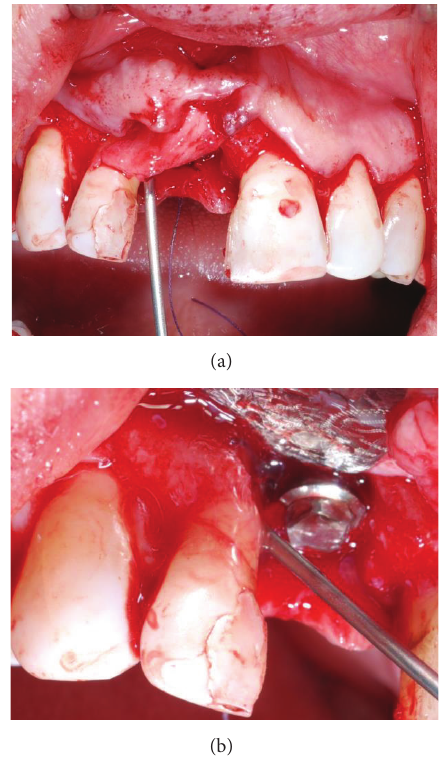
Figure 15: Frontal (a) and occlusal (b) view at the end of the surgical intervention.